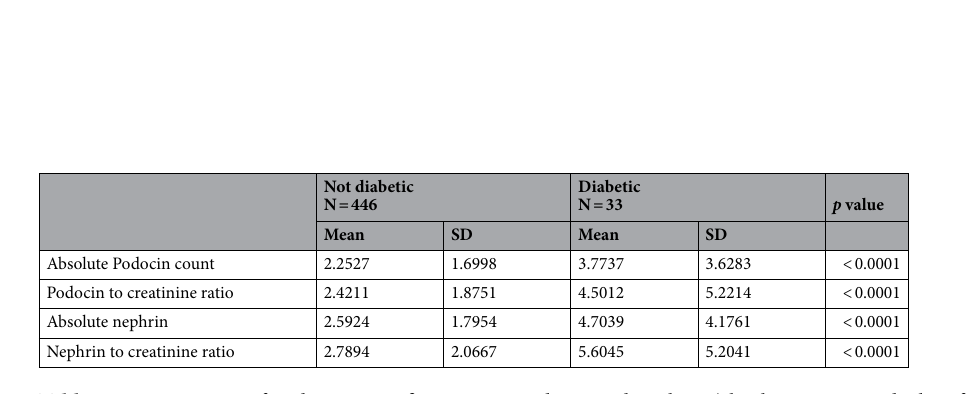
Table 5 . Mean copies of podocyte specific proteins: podocin and nephrin (absolute counts and when factored by mg creatinine in the urine) in the MESA sample stratified by diabetes